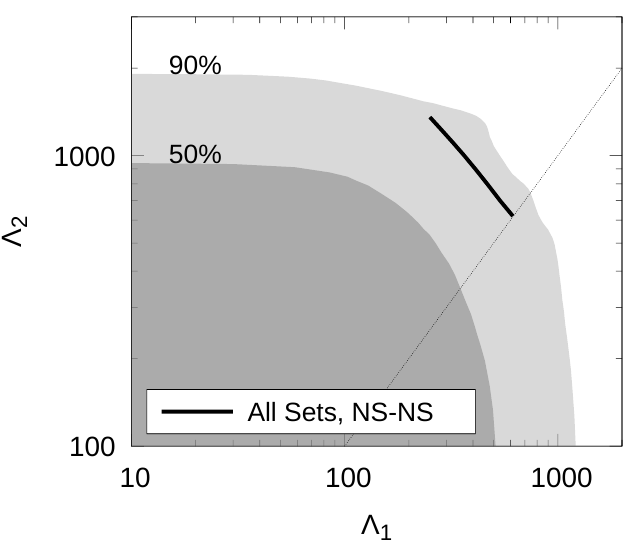
Figure 8. Text Dimensionless tidal deformabilities Λ 1 and Λ 2 for the selected EoSs. The solid black line represents the results obtained for a purely hadronic NS-NS merger with masses consistent with data from GW170817. The dark (light) gray areas represent the 50% (90%) confidence limit of the probability contour of GW170817 and the dotted line corresponds to Λ 1 = Λ 2